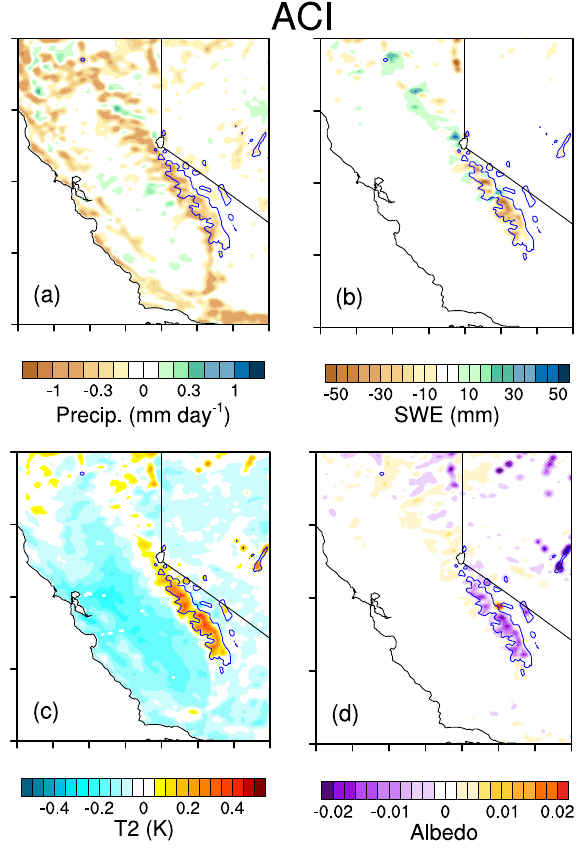
Figure 9. Same as Fig. 7, but for the ACI effect (NARS –